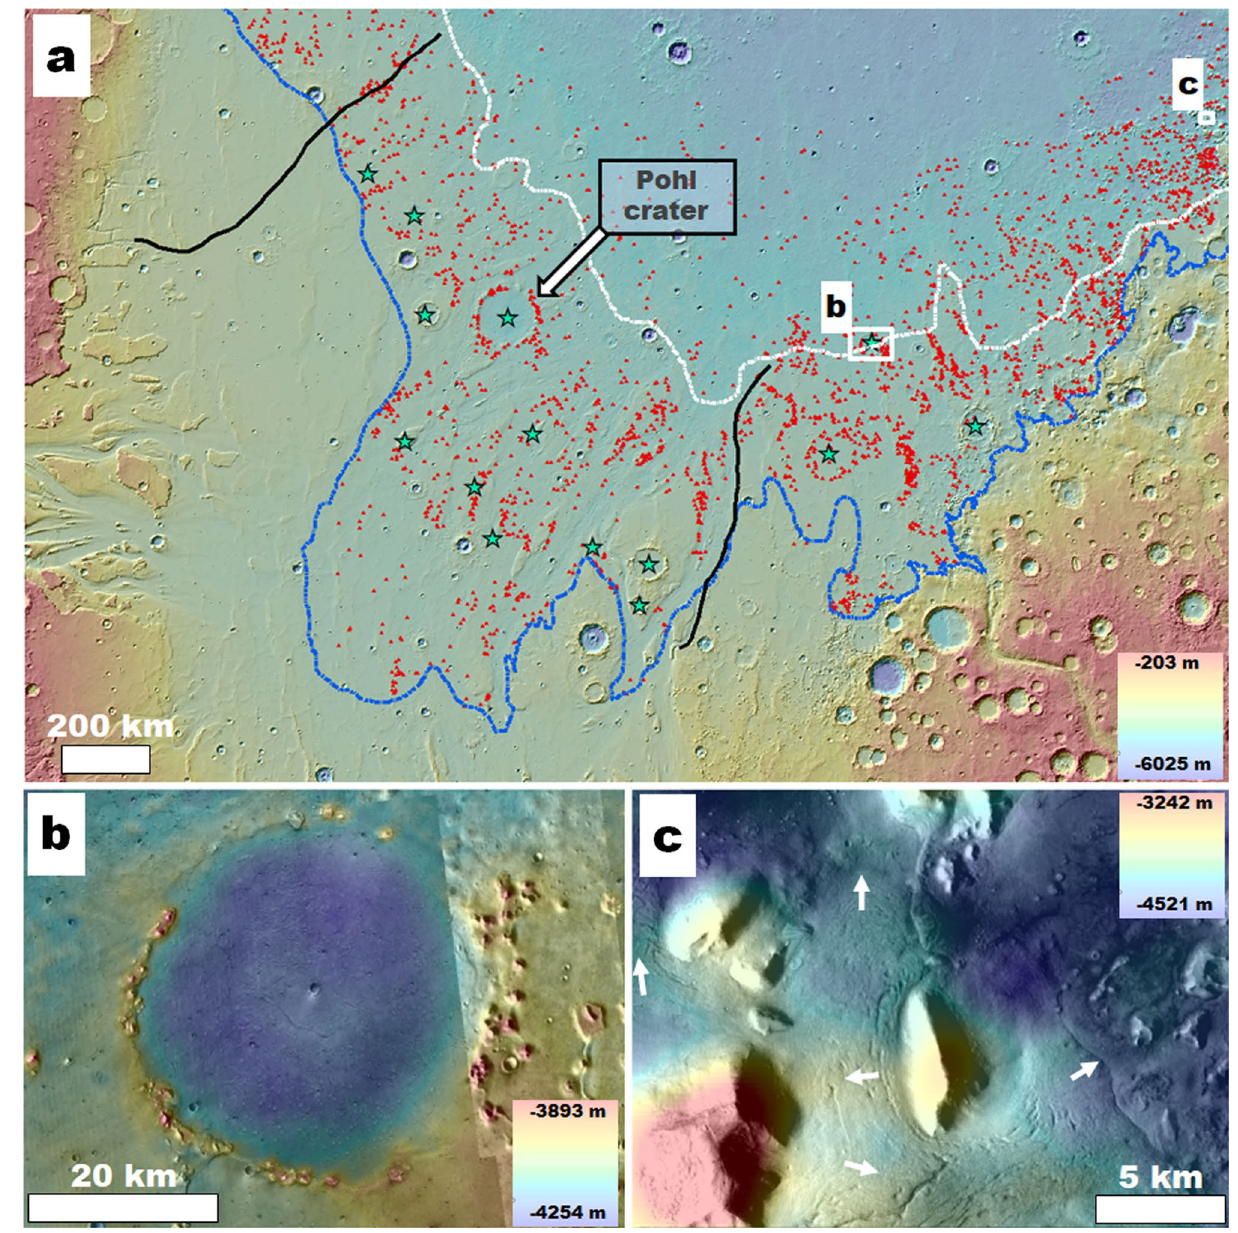
Figure 3. (a) View of Chryse Planitia showing the upper and lower paleoshoreline stands (blue and white lines, respectively). The black lines mark the margins of the regional surfaces affected by outflow channel dissection. The red symbols identify numerous knobs forming an extensive field within and north of a proposed paleo- oceanic area of regression from the higher to the lower paleoshoreline. Pohl is one of the field’s several knobby- rim craters (green star symbols). Color MOLA DEM (460 m per pixel, credit: MOLA Science Team, MSS, JPL, NASA) over a THEMIS nighttime IR global layer (http:// www. mars. asu. edu/ data/, 100 m per pixel, credit: Christensen, et al. 7 ). (b) Close-up view of one of the knobby-rim craters located outside the areas of outflow channel dissection. The knobs, such as observed at Pohl, exhibit no flow-related streamlining, suggesting that catastrophic flood erosion did not lead to the field’s formation. Color-coded shaded-relief MOLA digital elevation model (460 m per pixel, credit: MOLA Science Team, MSS, JPL, NASA) over part of a CTX mosaic (6 m per pixel, credit: NASA/JPL/Malin Space Science Systems (https:// www. msss. com/ mro/ marci/ images/ tips/ media tips. html) and a THEMIS daytime IR global layer (http:// www. mars. asu. edu/ data/, 100 m per pixel, credit: Christensen, et al. 7 ). (c) View of possible debris-covered glaciers with evidence of multiple directional flow patterns (e.g., white arrows) around and along the margins of knobs and mesas within the northeastern-most part of the mapped field, suggesting that glacial erosion contributed to its formation. Color-coded shaded-relief MOLA digital elevation model (460 m per pixel, credit: MOLA Science Team, MSS, JPL, NASA) over part of a CTX mosaic (6 m per pixel, credit: NASA/JPL/Malin Space Science Systems (https:// www. msss. com/ mro/ marci/ images/ tips/ media tips. html). We produced this figure using Esri’s ArcGIS 10.3 (http:// www. esri. com/ softw are/